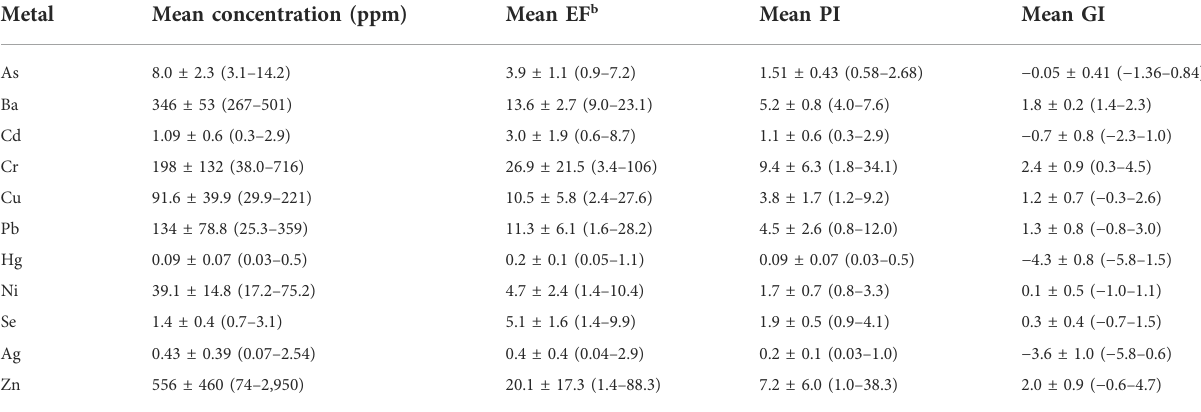
TABLE 1 Summary of concentration (ppm), enrichment factor (EF)*, pollution index (PI)*, and geoaccumulation. Index (GI)* of Heavy Metals ( n =